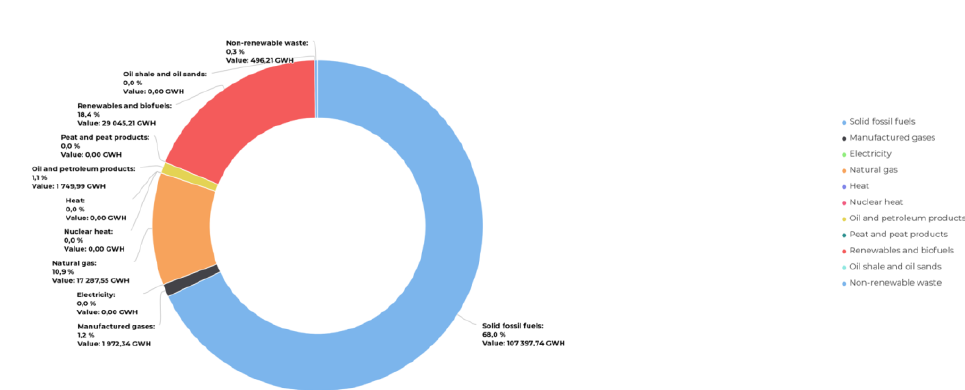
Figure 6. Gross electricity production structure in Poland—2000 vs. 2020. Source: Eurostat data [19].